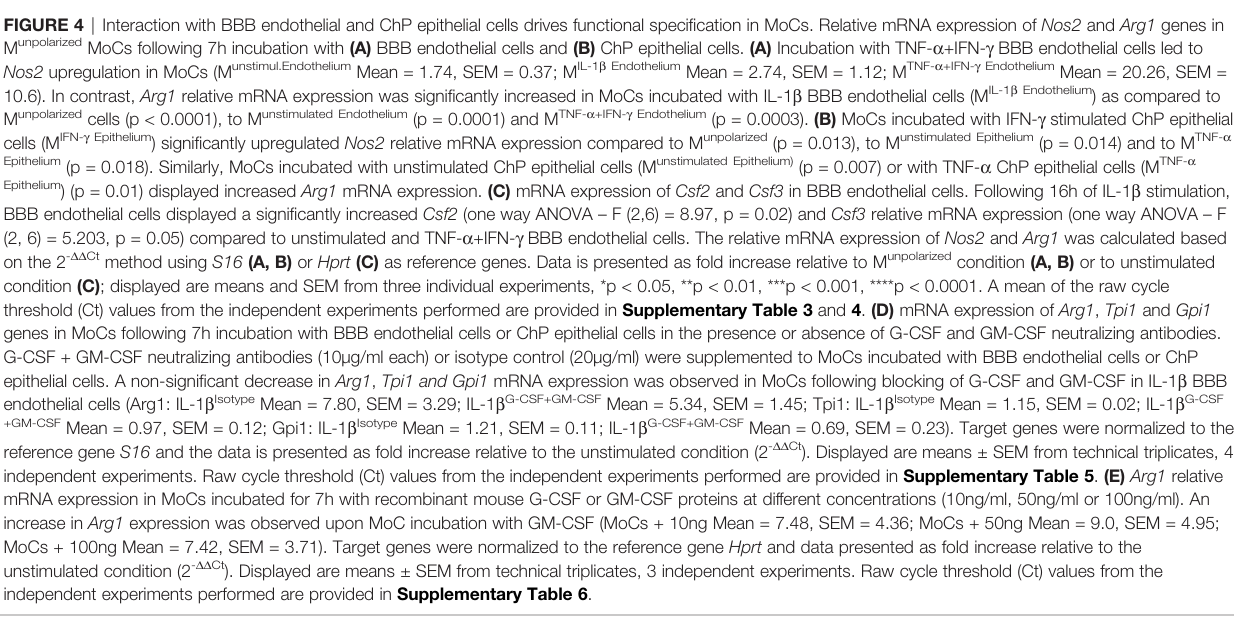
independent experiments. Raw cycle threshold (Ct) values from the independent experiments performed are provided in Supplementary Table 5 . (E) Arg1 relative mRNA expression in MoCs incubated for 7h with recombinant mouse G-CSF or GM-CSF proteins at different concentrations (10ng/ml, 50ng/ml or 100ng/ml). An increase in Arg1 expression was observed upon MoC incubation with GM-CSF (MoCs + 10ng Mean = 7.48, SEM = 4.36; MoCs + 50ng Mean = 9.0, SEM = 4.95; MoCs + 100ng Mean = 7.42, SEM = 3.71). Target genes were normalized to the reference gene Hprt and data presented as fold increase relative to the unstimulated condition (2 - DD Ct ). Displayed are means ± SEM from technical triplicates, 3 independent experiments. Raw cycle threshold (Ct) values from the independent experiments performed are provided in Supplementary Table 6